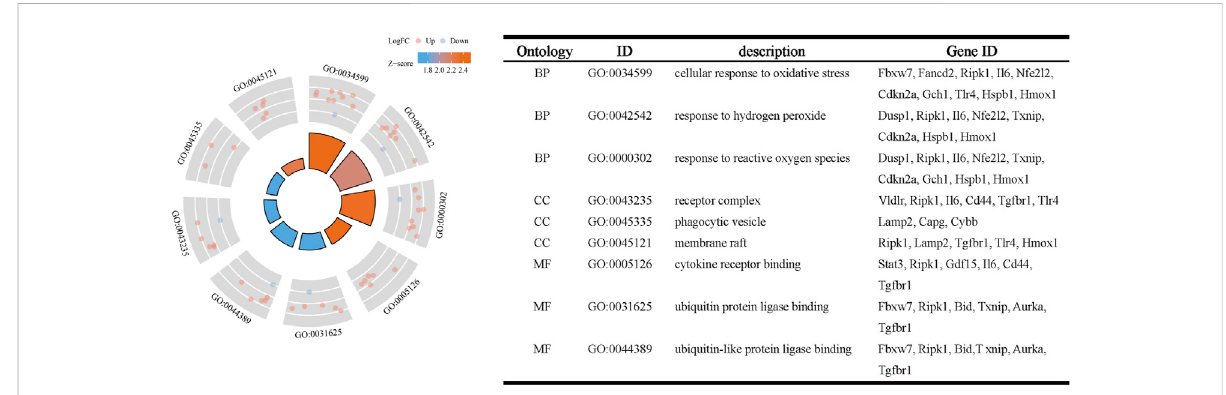
FIGURE 2 Gene ontology enrichment analysis of ferroptosis-related DEGs.